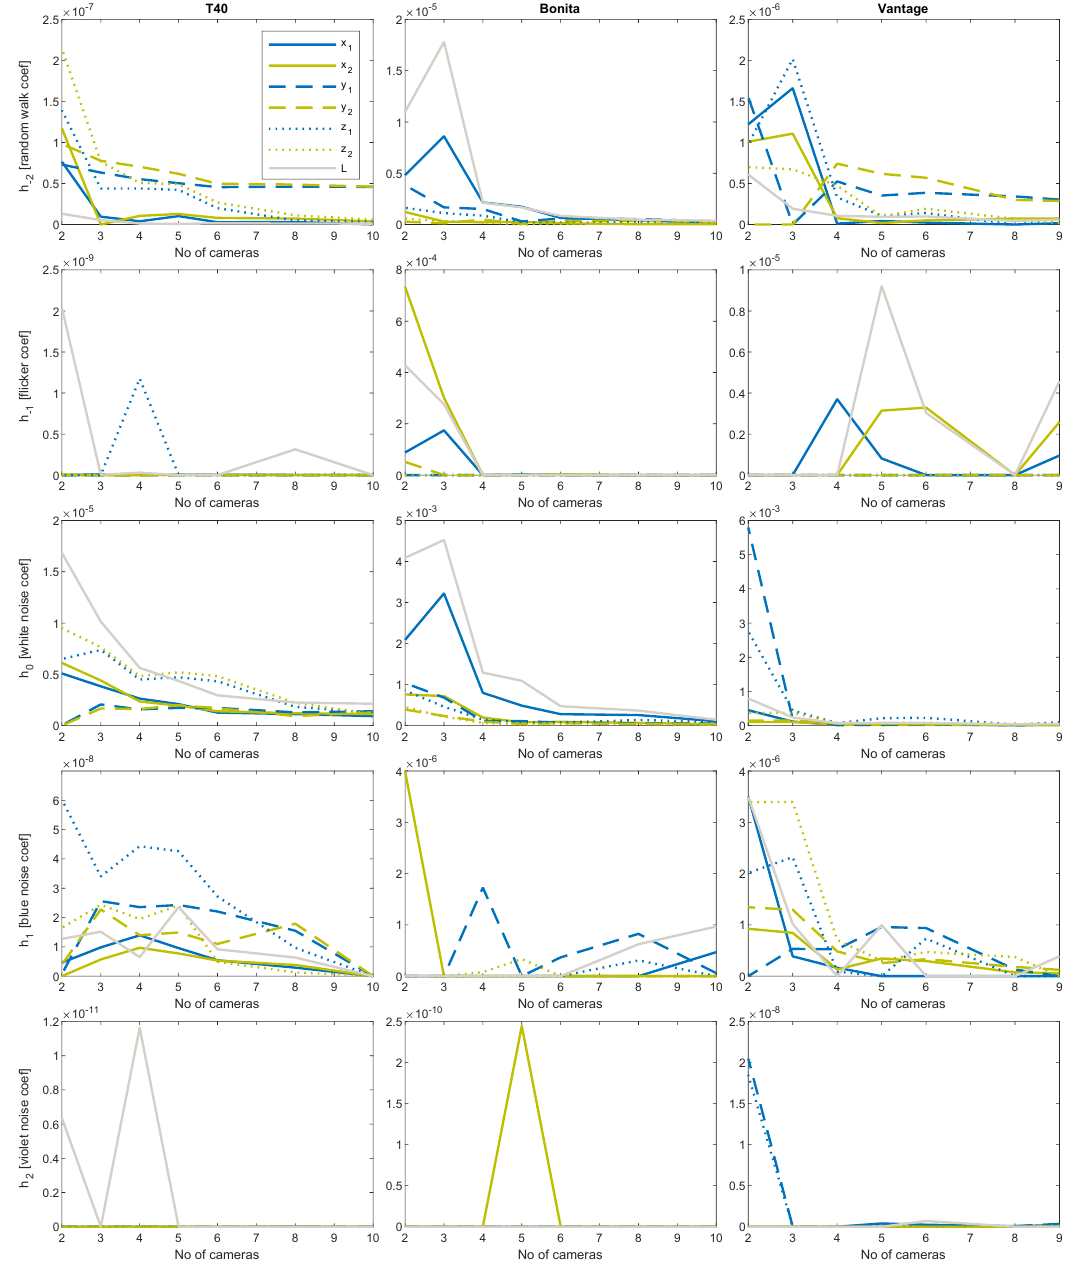
Figure 15. Color noises ( h − 2 ... h 2 ) coefficients in linear scale; in columns left to right: T40, Bonita,